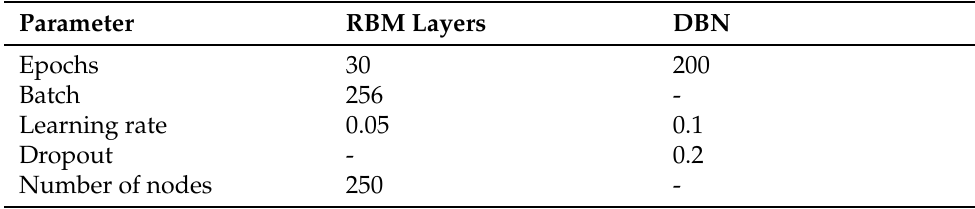
Table 4. Parameters configuration of RBM layers and